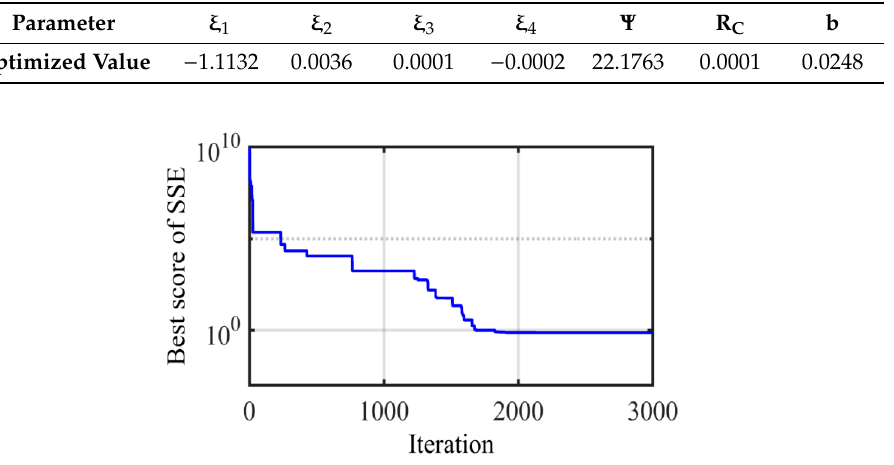
Table 4. Estimated parameters by the ASO for the 250 W stack.